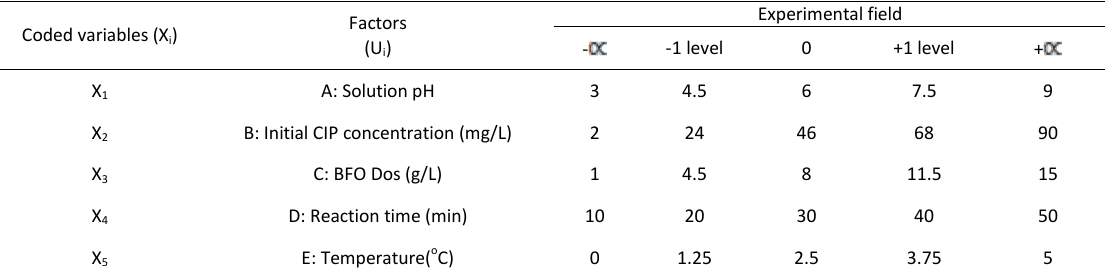
Table 1: Coded and actual values of numeric factors